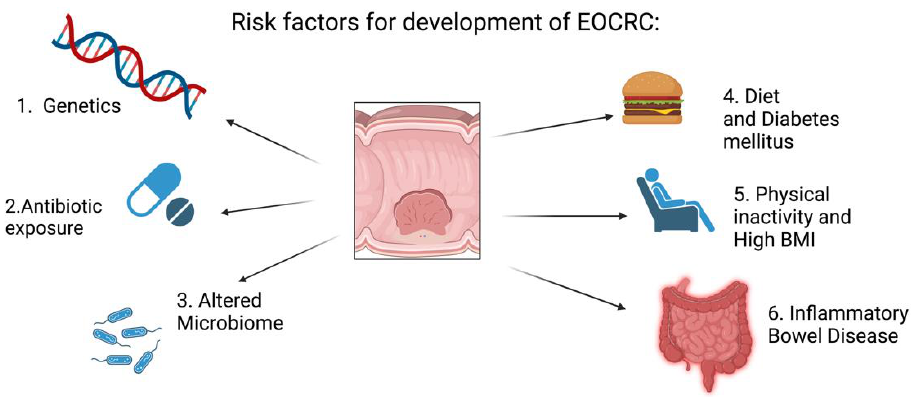
Figure 1. Risk factors for the development of EOCRC. Figure developed using